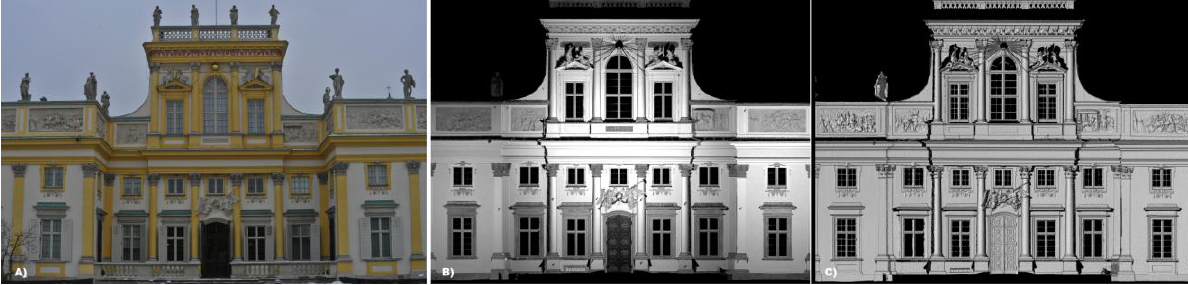
Figure 1. Data used in the calibration process: A) one of the images used for calibration, B) the intensity orthoimage, C) the shaded DSM in the form of an